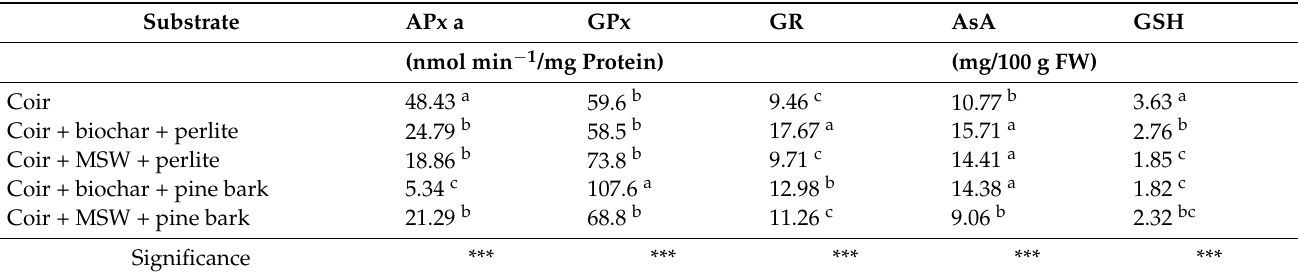
Table 7. Effect of substrates on the ascorbate-glutathione